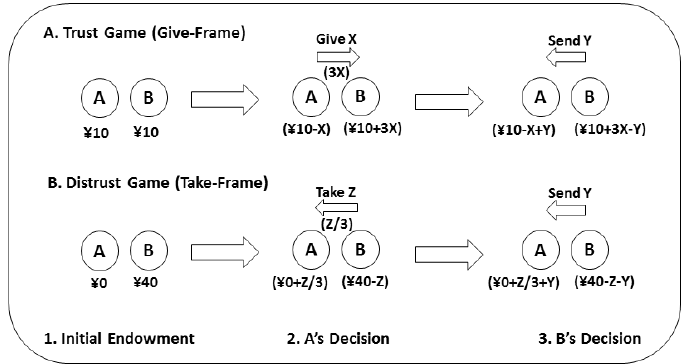
Figure 4. Types of game frames. ( A ). Trust Game (Give-Frame). 1. Initial Endowment. Both players A and B are endowed with ¥10. 2. A’s Decision. A decides whether to keep the endowment or send any amount X ∈ [¥0, ¥1, . . . , ¥10] to B, which is afterward tripled by the experimenter (3*X, ranging from ¥3 to ¥30). 3. B’s Decision. B decides whether to keep or return any amount Y ∈ [¥0, ¥1, . . . , ¥10 + 3*X] of the received money to A. ( B ). Distrust Game (Take-Frame): 1. Initial Endowment. Only B is endowed with ¥40, and A has ¥0. 2. A’s Decision. A decides whether to leave the endowment to B or take any amount Z ∈ [¥0, ¥3, . . . , ¥30] (Z = 3*(¥10 − X), X ∈ [¥0, ¥1, . . . , ¥10]) from B, which is afterward divided by three by the experimenter (Z/3, ranging from ¥1 to ¥10). 3. B’s Decision. B decides whether to keep or send any amount Y = [¥0, ¥1, . . . , ¥40 − ¥Z] to A. Note that trust is calculated for the trust game as the amount given by A (X) and for the distrust game as the amount not taken by A (¥10 − Z/3), and reciprocity in both games as the ratio of the amount sent